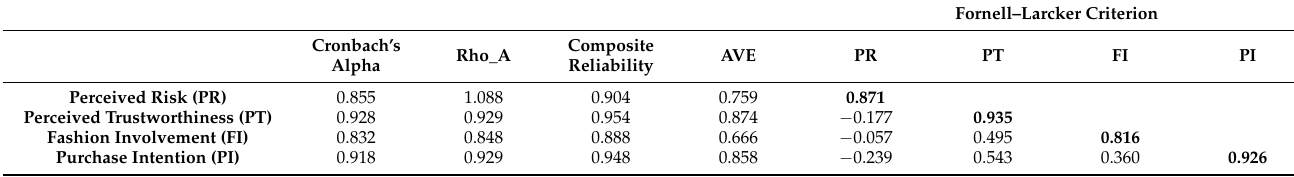
Table 3. Internal consistency, convergent and discriminant validity of the measurement